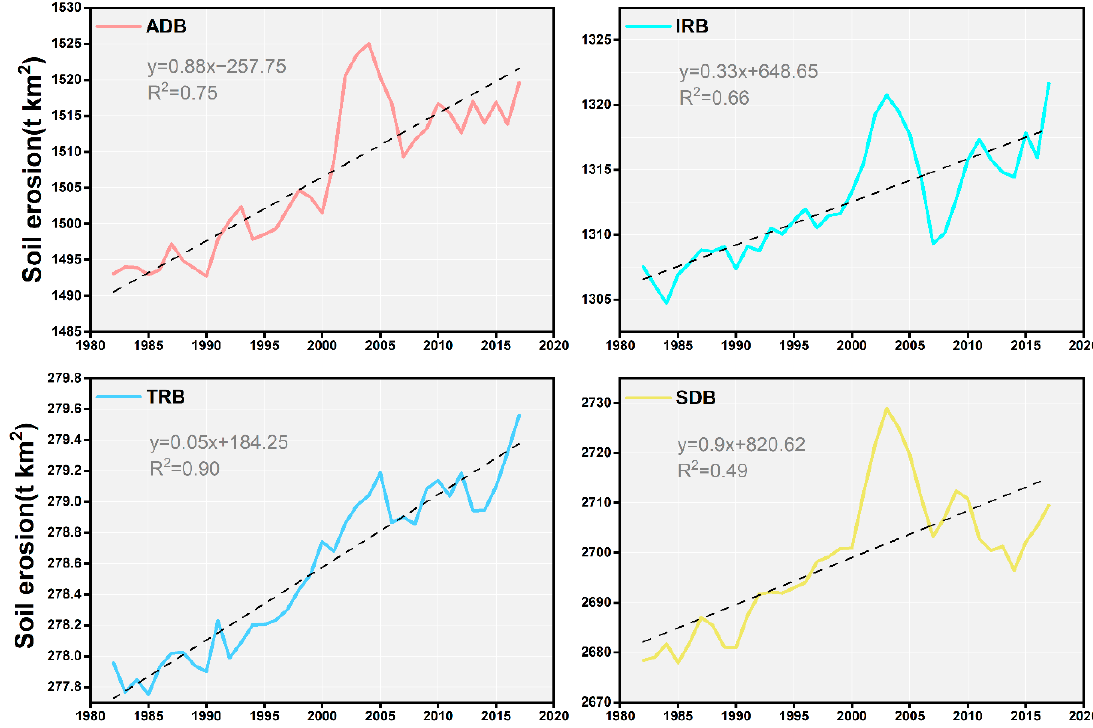
Figure 6. Temporal variations in annual SE from 1982 to 2017. ADB, Amu Darya Basin; SDB, Syr Darya Basin; IRB, Ili River Basin and TRB, Tarim River Basin.